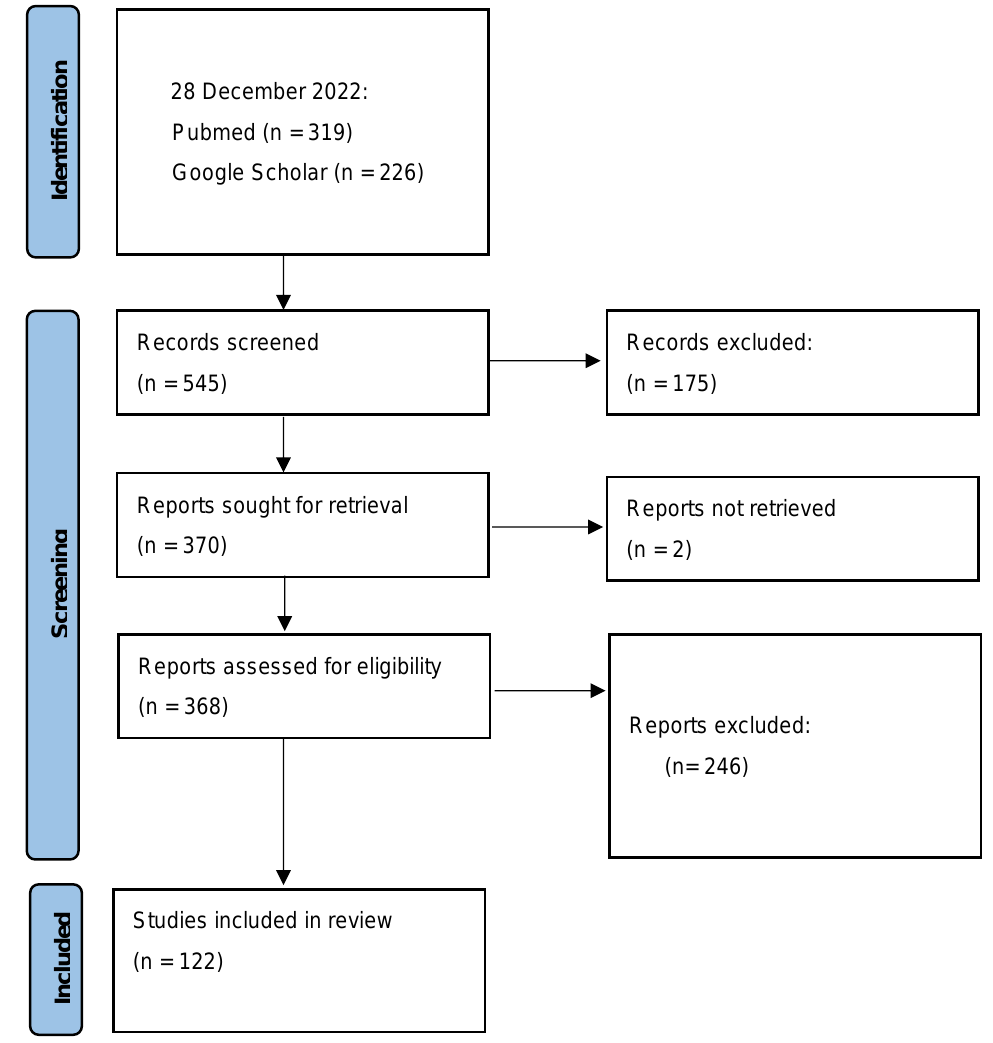
Figure 2. Preferred Reporting Items for Systematic Reviews and Meta-Analyses (PRISMA) flow